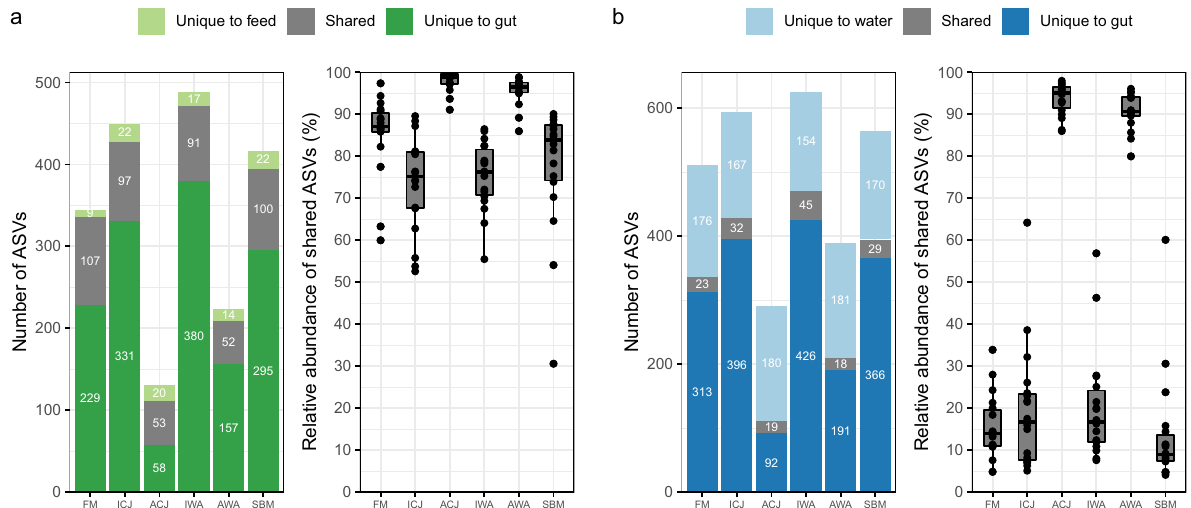
Fig. 4 The microbial overlap between the gut and feeds ( a ) and between the gut and the water ( b ). The number of shared amplicon sequence variants (ASVs) is shown in the left figure of each panel. The relative abundance of shared ASVs is shown in the right figure of each panel. The minimum relative abundance of ASVs to be considered as present in a sample was 0.05%. The samples are grouped by diets;